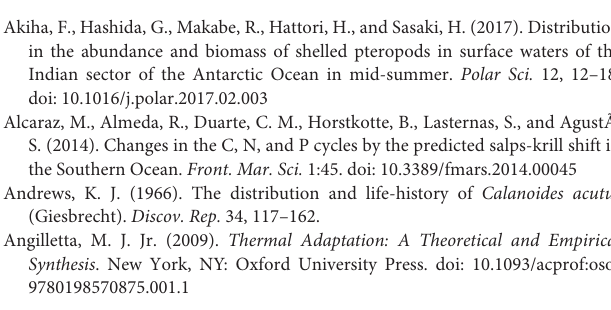
Pinkerton et al. (2020) showing average modelled daily abundance (counts per 5 nautical mile CPR segment) over the 6 months (October to March) and years 1998–2018. No analysis was possible for areas shown in white, for example because environmental conditions were outside the observations. Black lines are nominal positions of (from north): Subantarctic Front, Antarctic Polar Front, average maximum northern extent of seasonal sea ice (dashed), and the Southern Boundary of the Antarctic Circumpolar Current. Supplementary Figure 2 | Modelled environmental suitability for (A) total zooplankton, i.e., Euphausiidae, Copepoda (Calanoida and Oithona similis ), and pteropods, (B) Euphausiidae, (C) Copepoda (Calanoida), (D) Oithona similis , and (E) pteropod abundance from the combined Boosted Regression Tree model of Pinkerton et al. (2020) showing long-term, linear trends in abundance (trend units are 1000 counts per 5 nautical miles of CPR segment per year). Sen slope values showing the changes in modelled abundance at each point. Colored vales are significant ( p < 0.05). Warm colors indicate a positive (increasing) trend in the environmental suitability, and cold colors a negative (decreasing) trend. White areas have no significant trend. Areas shown gray have no data. Black lines are nominal positions of (from north): Subantarctic Front, Antarctic Polar Front, average maximum northern extent of seasonal sea ice (dashed), and the Southern Boundary of the Antarctic Circumpolar Current. Supplementary Figure 3 | Time series of change in environmental suitability for total zooplankton abundance, i.e., Euphausiidae, Copepoda (Calanoida and Oithona similis ), and pteropods, from the combined Boosted Regression Tree model of Pinkerton et al. (2020) for individual Marine Ecosystem Assessment for the Southern Ocean (MEASO) Areas. Imbedded three letter codes in figure relate to MEASO sectors (first two letters) and zones (last letter). Sectors are Atlantic (AO), Central Indian (CI), East Indian (EI), West Pacific (WP), and East Pacific (EA). Zones are Antarctic (A), Subantarctic (S), Northern (N). See also Figure 1 in main paper. The environmental suitability anomaly (difference from the monthly climatological value) is shown for each month over period 1998–2018. Gray shading indicates calendar years. Black points and lines are monthly anomalies (differences from long-term monthly means). Red lines are smoothed changes (4-year running median). Supplementary Table 1 | Current role of zooplankton in Southern Ocean ecosystems (based on information provided in taxonomic Sections Euphausiids (Family Euphausiidae), Copepods (Subclass Copepoda), Salps (Order Salpida), and Pteropods (Order Pteropoda)). Roles may vary across areas of the Southern Ocean, seasons, or with life history stages. See Figure 1 for locations and key to MEASO areas. See Supplementary Table 2 for environmental tolerances. Supplementary Table 2 | Environmental tolerances of zooplankton in Southern Ocean ecosystems (based on empirical studies). n/a = data not available. Supplementary Table 3 | Future prognoses* for Southern Ocean zooplankton in response to changes in key physical, chemical, and ecological drivers (based on information provided in Sections Euphausiids (Family Euphausiidae), Copepods (Subclass Copepoda), Salps (Order Salpida), Pteropods (Order Pteropoda), and Past Changes in Zooplankton: A modelled example using Continuous Plankton Recorder Data (including references cited therein)) and Supplementary Tables